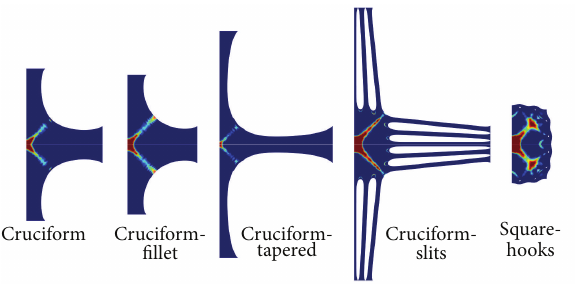
Figure 10: Contour maps of biaxiality index 𝑅 biax